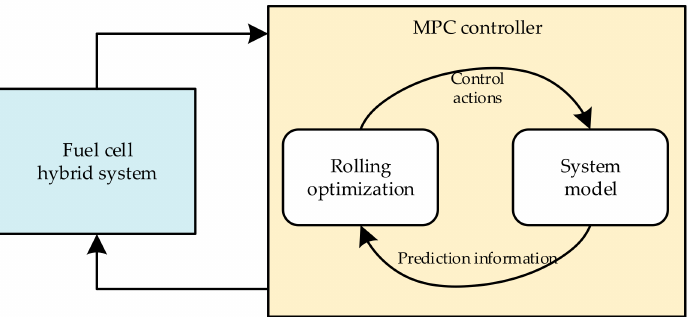
Figure 6. Basic principles of model predictive